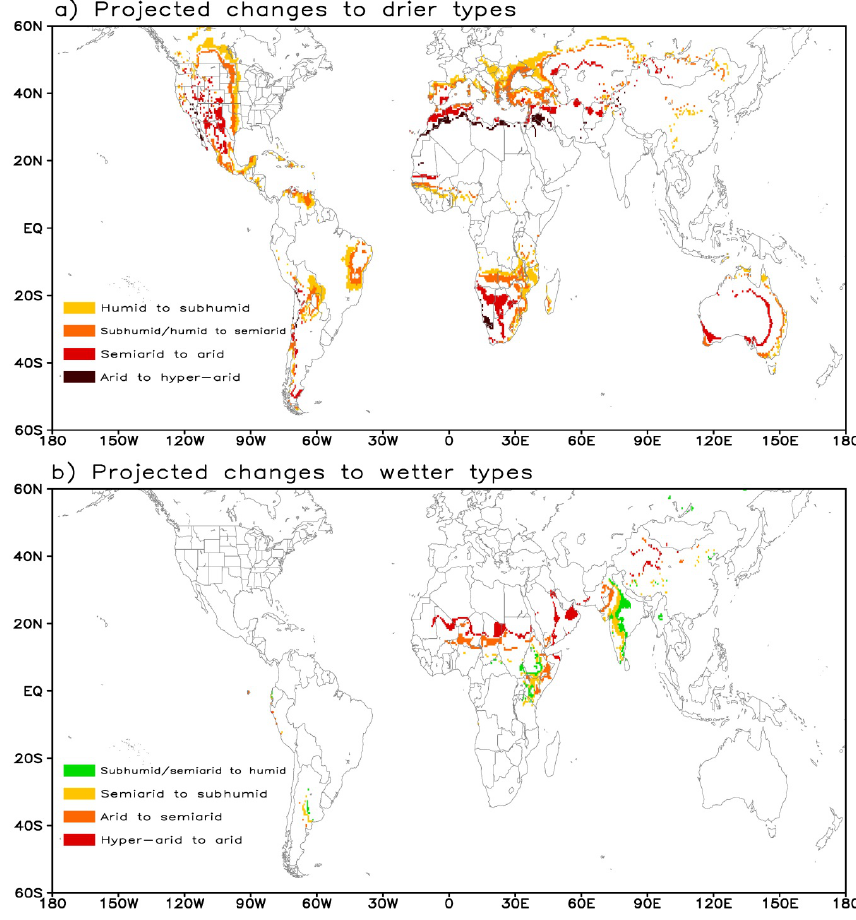
Fig. 5. (a) projected changes in coverage to drier types for 2071–2100 under scenario RCP8.5 relative to 1961–1990, and (b) same as (a) but to wetter types, based on the ensemble average of the 27